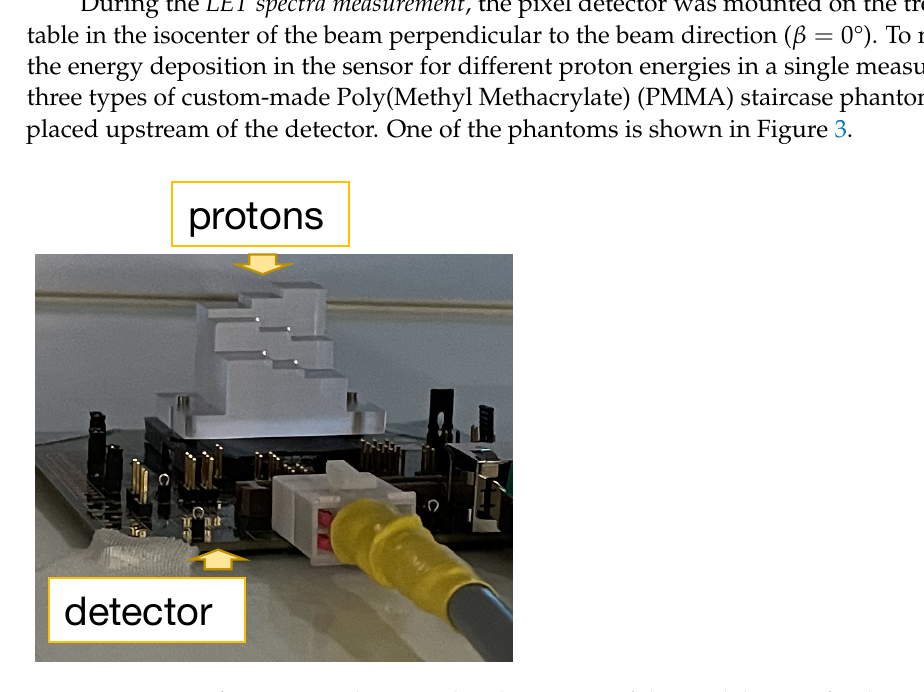
Figure 3. Picture of a staircase phantom placed upstream of the pixel detector for the LET spectra measurement